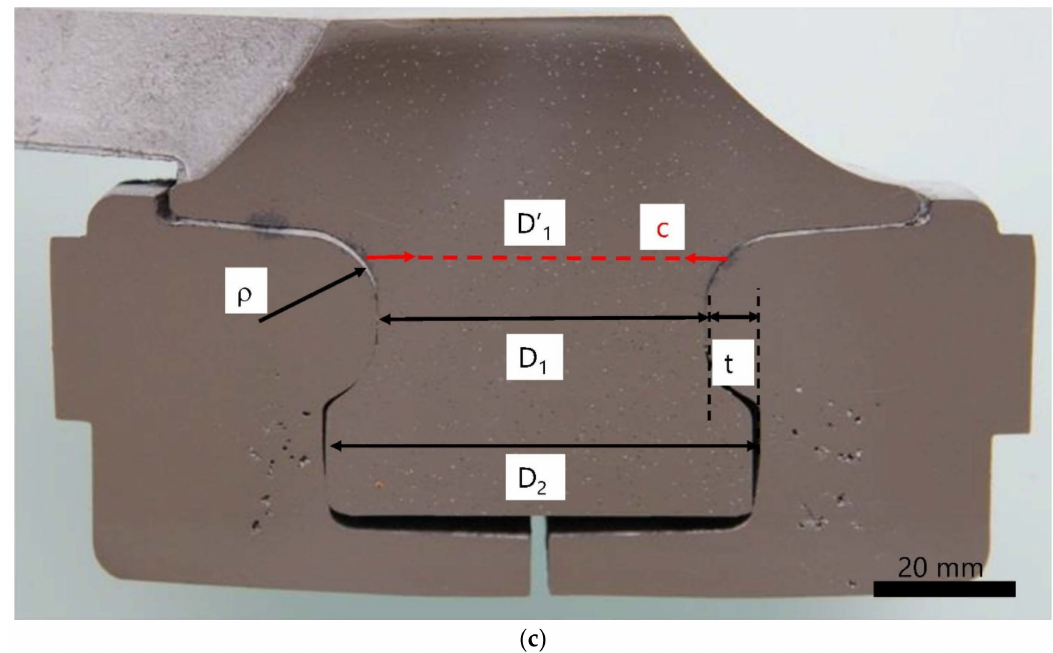
Figure 5. Crack size for the stress intensity models: ( a ) lower bound, ( b ) upper bound (top view), and ( c ) upper bound (section view). Variables of the fracture mechanics model: ρ = groove radius, D (cid:48) 1 = diameter in the cracked section, D 1 = diameter of the smaller section, D 2 = diameter of the lager section, t = shoulder depth, c = crack